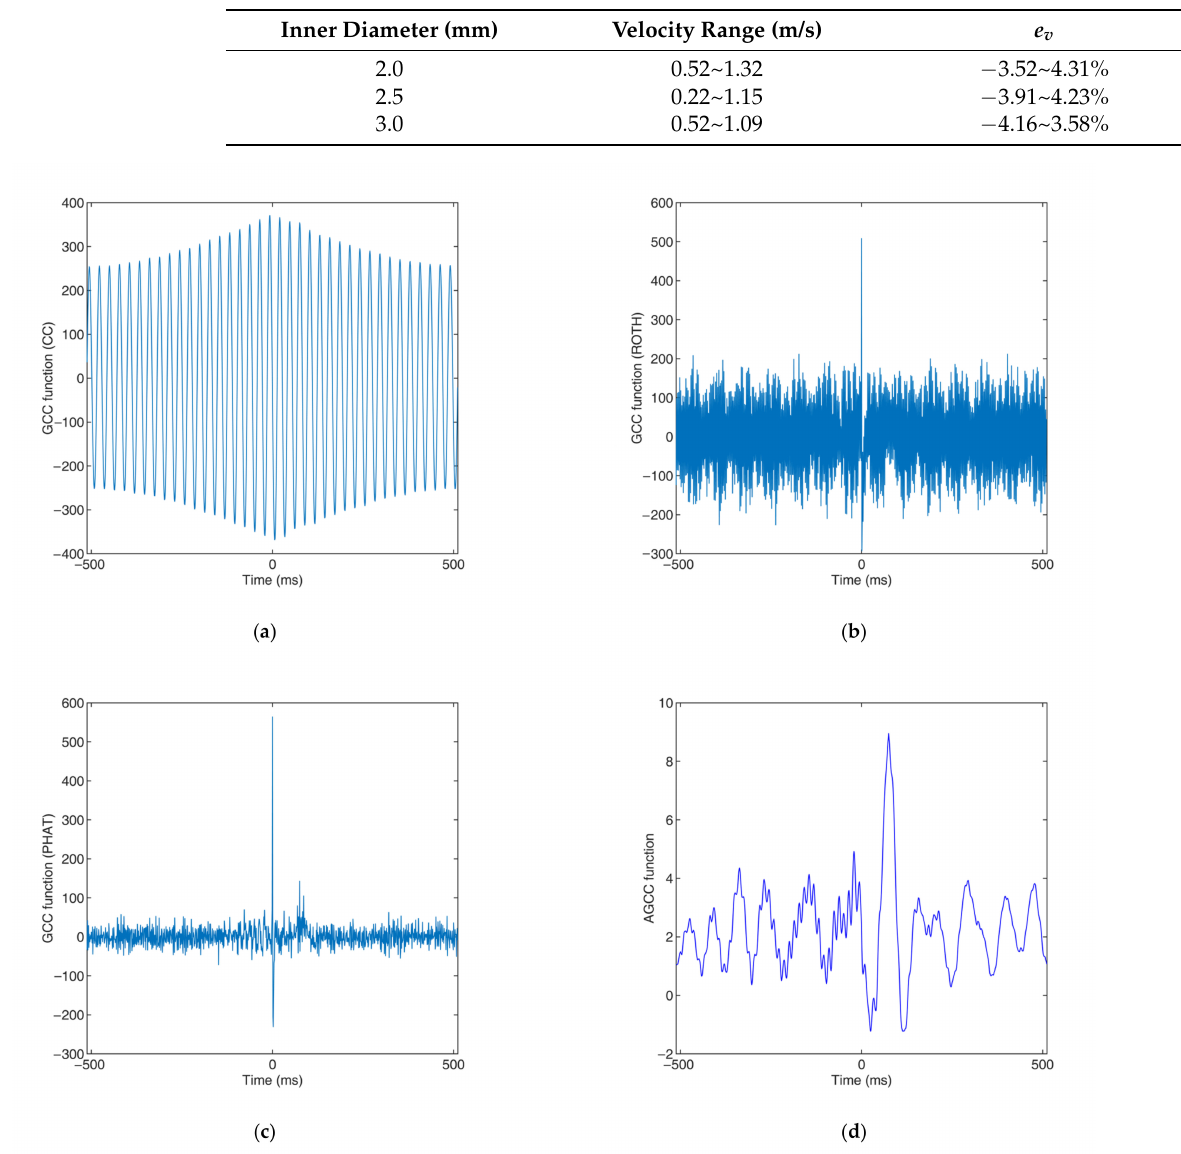
Figure 15. CC and GCC functions of slug flow with strong periodicity: ( a ) basic CC (obtained time delay, − 7.0 ms; measured velocity, − 4.29 m/s; e v = − 1145.30%); ( b ) GCC method with Roth (obtained time delay, 0 ms; no meaningful measured velocity); ( c ) the GCC method with PHAT (obtained time delay, 0 ms; no meaningful measured velocity); ( d ) the proposed AGCC method (obtained time delay, 75 ms; measured velocity, 0.40 m/s; e v = −